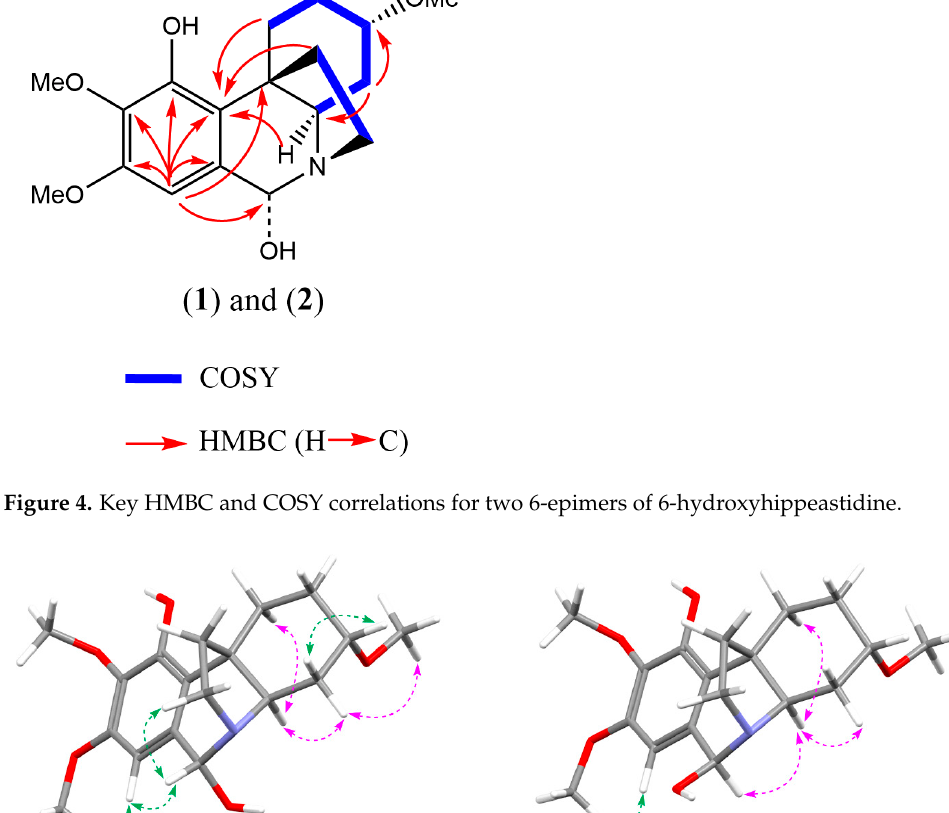
NOESY correlations in front of the plane ( β -orientation); pink arrows: NOESY correlations behind